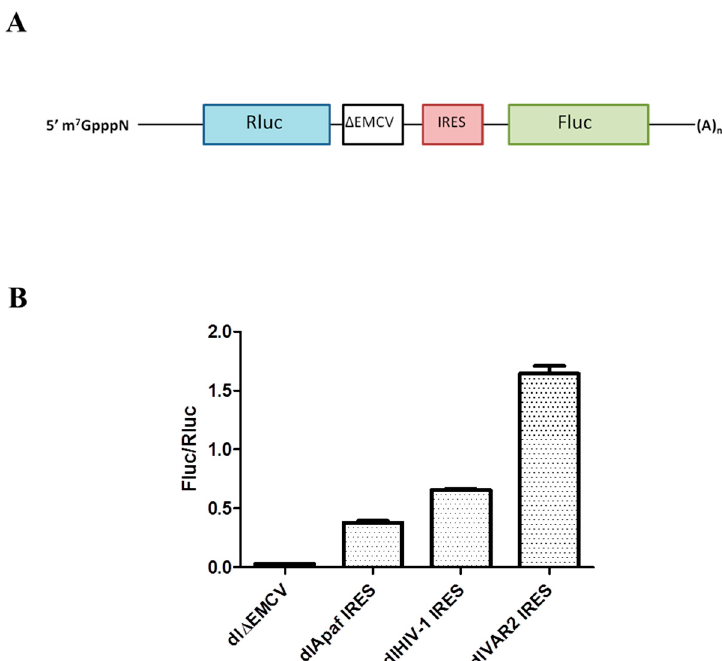
Figure 1. IRES activity measured by a dual luciferase assay. ( A ) Scheme of the construct used to perform the dual luciferase test. The IRES of interest is inserted into a dual luciferase construct (dl) between an upstream Renilla luciferase gene (Rluc) and the ∆ EMCV defective IRES and a downstream firefly luciferase gene (Fluc). ( B ) Activity test in HeLa cells of dlApaf-1 IRES, dlHIV-1 IRES and dlVAR2 IRES. The dl ∆ EMCV IRES was used as a negative control. The IRES activity is monitored by the ratio of Fluc/Rluc luciferase activities. Measurements were performed in HeLa cells 24 h post transfection. Histograms represent the mean ± SEM for at least 3 independent experiments done in triplicate.